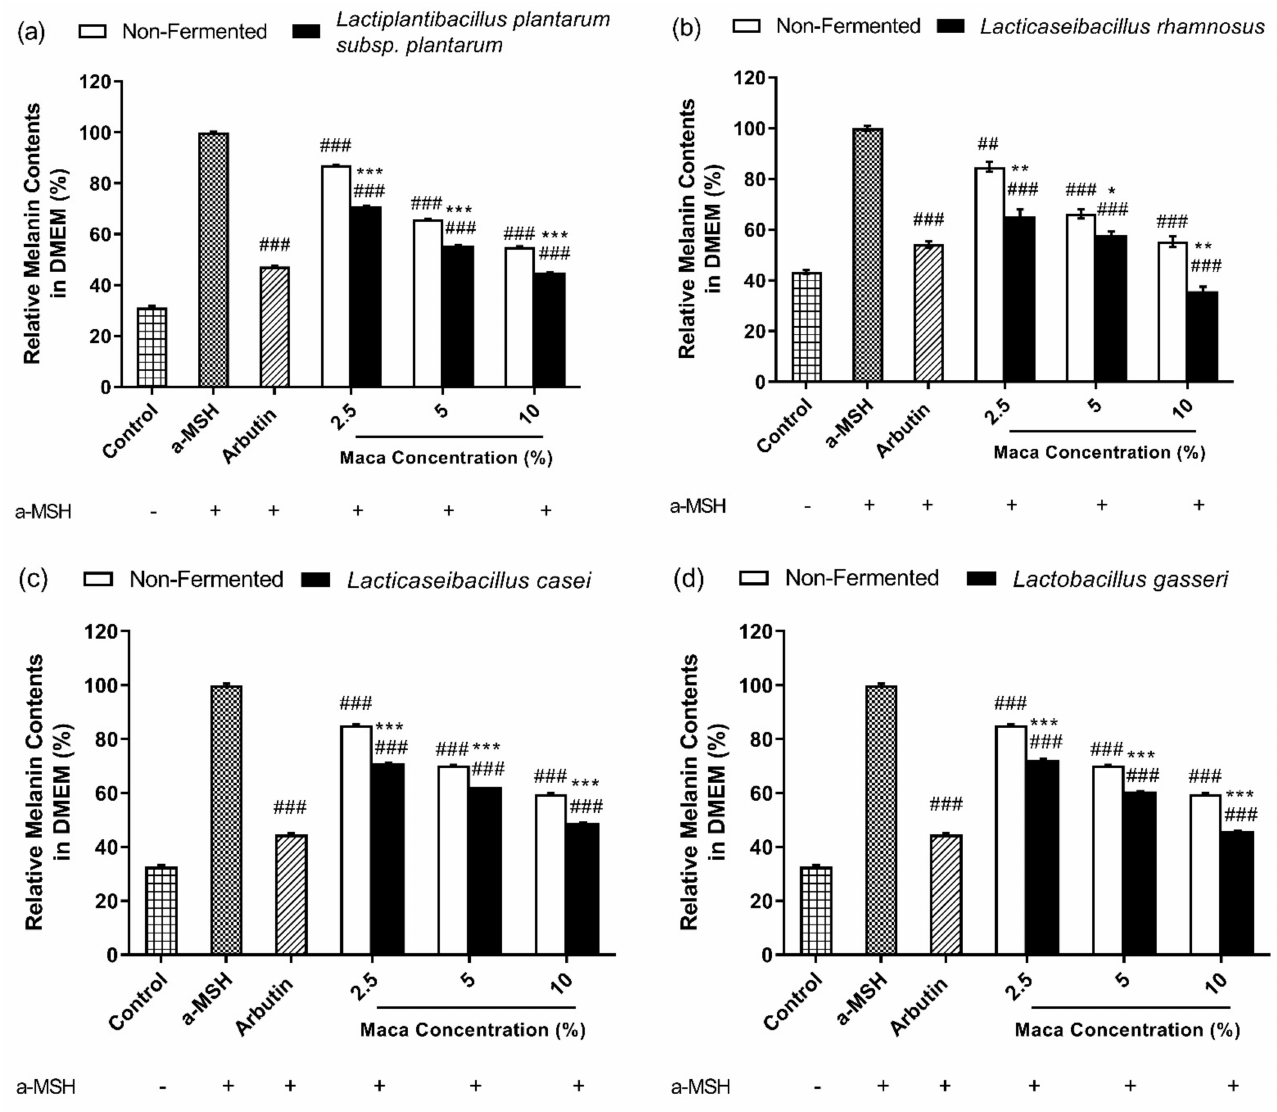
Figure 8. Effects of non-fermented and fermented maca root extracts on extracellular melanin content. Extracellular melanin content of B16F10 cells treated with maca root extracts fermented using ( a ) Lactiplantibacillus plantarum subsp. plantarum KCTC 3108, ( b ) Lacticaseibacillus rhamnosus KCTC 5033, ( c ) Lacticaseibacillus casei KCTC 3109, and ( d ) Lactobacillus gasseri KCTC 3143. Error bars, mean ± SD. ## p < 0.005 and ### p < 0.0005 compared to α -MSH group, * p < 0.05, ** p < 0.005, and *** p < 0.0005 compared to the same concentration of non-fermented maca root